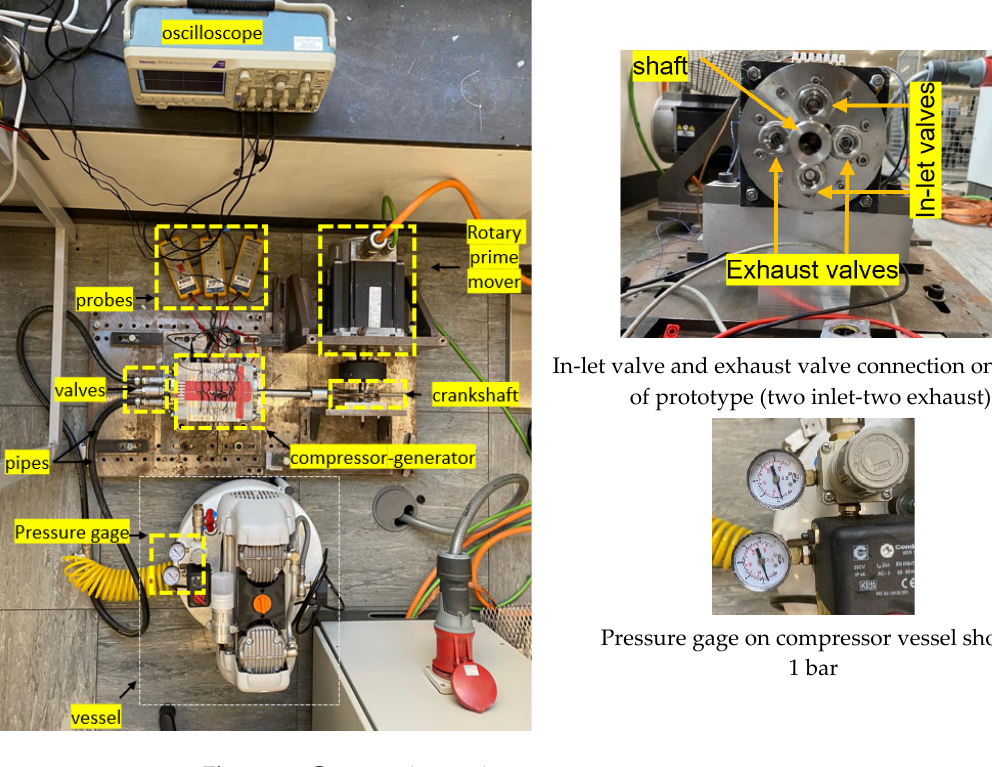
Figure 29. Compression testing